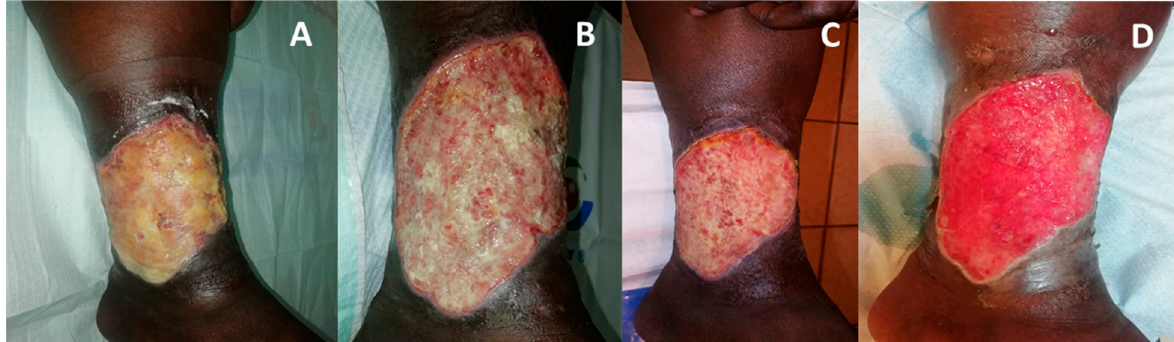
Figure 5. Closure of a wound in a NIDDM patient (Case Report 3). ( A , B ) The patient underwent right-leg fifth toe amputation due to osteomyelitis and continued infection on 17 October 2019. ( C ) After 20 days of SOC including 10 VAC sessions, the patient was discharged home on 7 November and the wound was covered with the COD. ( D ) Two days of COD treatment. ( E ) Ten days of COD treatment. ( F ) Seventeen days of COD treatment. ( G ) Thirty-one days of COD treatment. ( H ) Fifty-five days of COD treatment. ( I ) After 77 days of COD treatment the wound was completely closed and the COD treatment was stopped. ( L , K ) The wound remained solidly closed 20 days after wound closure.